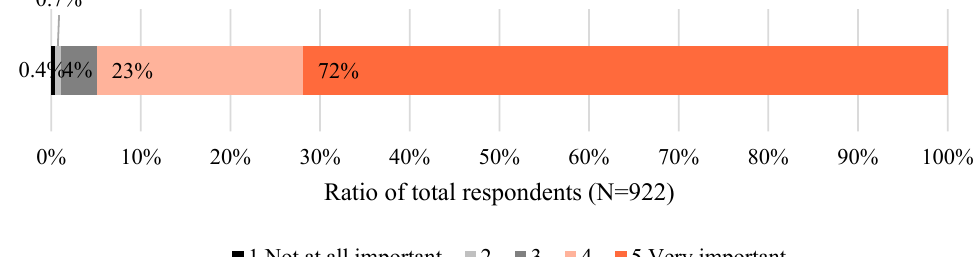
Figure 1. Importance of using renewables instead of fossil fuels.